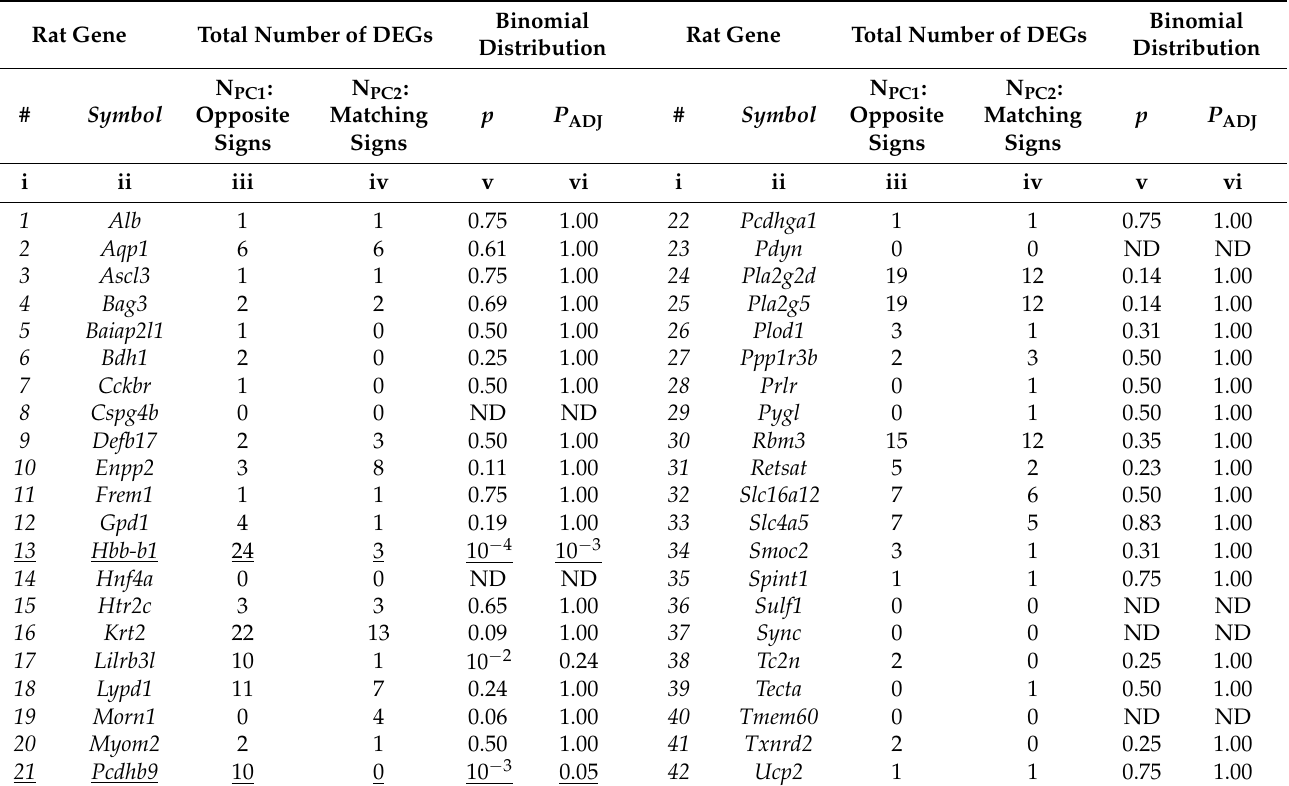
Table 6. Searching for hypertension-related molecular markers among the human genes orthologous to the 42 hippocampal DEGs (of tame versus aggressive rats) identified in this work. Here, we took into account the number of their homologous DEGs in the tissues of hypertensive versus normotensive subjects (patients and